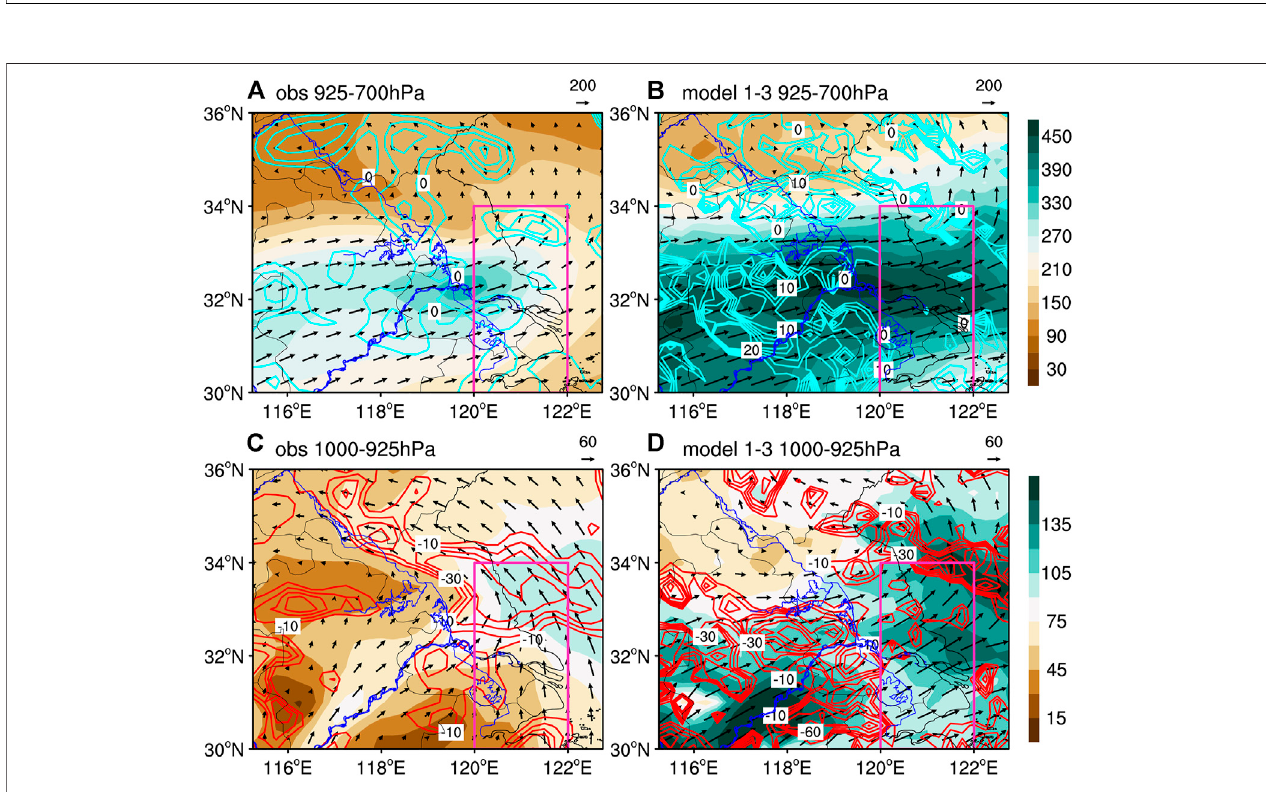
FIGURE 9 | Composites of the vertical integrated water vapor fl ux ( kg · m − 1 · s − 1 , vectors with corresponding magnitudes denoted by shading ) and